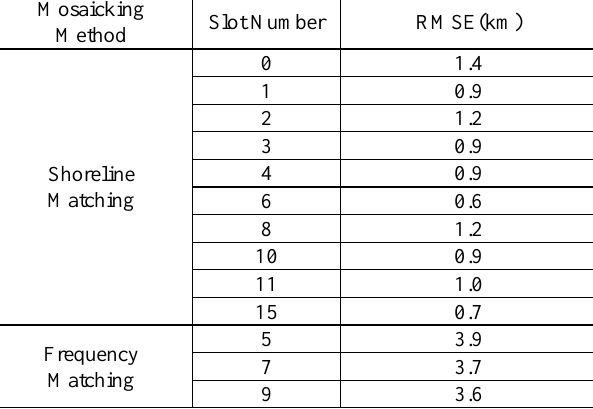
Table 1. RMSE analysis of second experiment result